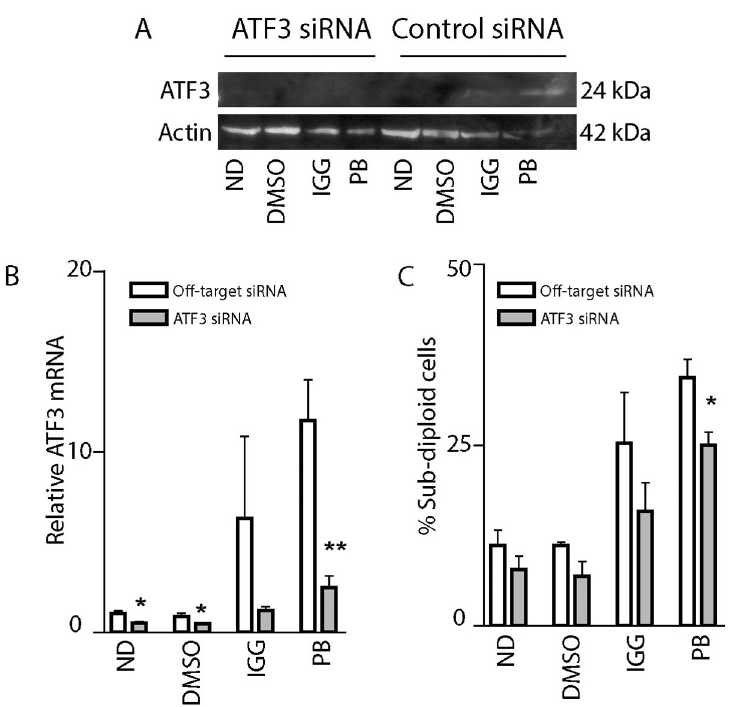
Fig 4. Knockdown of ATF3 protects HeLa cells from IGG- and PB-induced apoptosis. HeLa cells were transfected with control non-targeting or anti-ATF3 siRNAs, split into separate dishes for RNA, protein, and apoptosis analysis. Transfected cells were subsequently exposed to the indicated drugs (30 μ M IGG or 25 nM PB), no drug control (ND) or vehicle control (DMSO) for up to 48 hours. (A and B) Twenty-four hours following treatment, protein and RNA samples were collected for immunoblot (A) and qRT-PCR analysis (B). Similar immunoblot results were obtained over from three independent experiments. Each value in B represents the mean +/- SEM determined from three independent experiments. (C) Sensitivity to IGG- and PB-induced apoptosis was assessed by flow cytometric analysis of subG 1 DNA content. Each point represents the mean +/- SEM determined from three independent experiments. The � and �� in B and C indicate that the value is significantly different from the corresponding non-targeted siRNA transfected control sample (p < 0.05 and p < 0.01, respectively), as determined using unpaired t-tests.